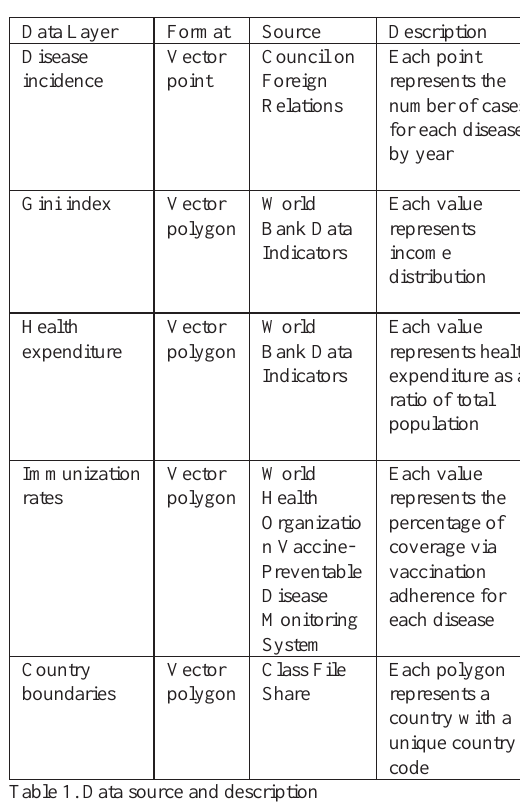
Table 1. Data source and